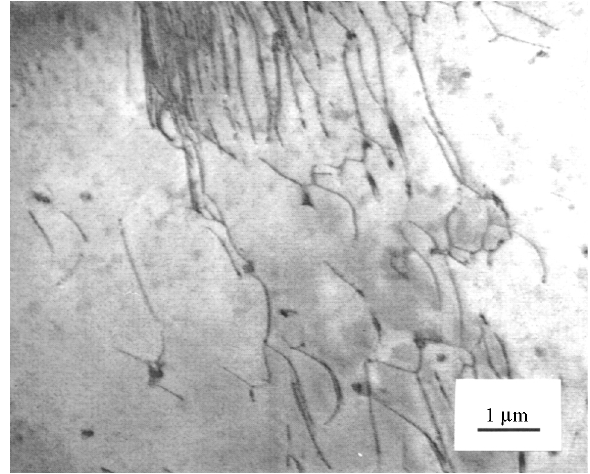
Figure 6. TEM observation of dislocations structure of a specimen annealed.